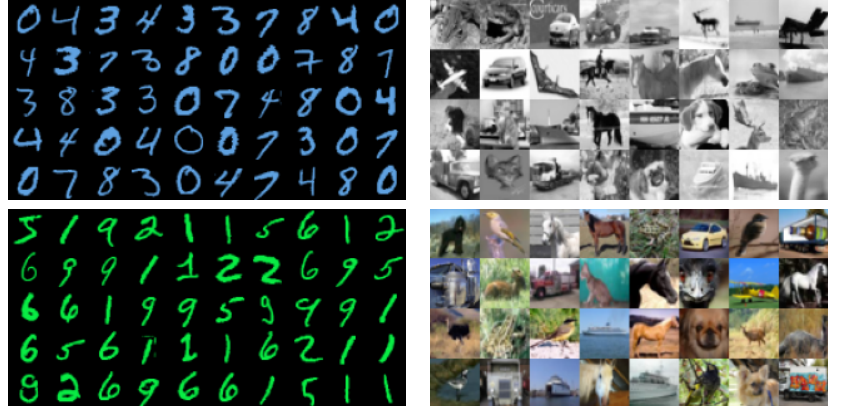
Figure 2. Examples of the images in the (modified) benchmark datasets. Left: The colored digits in the 2cMNIST dataset. These are generated by coloring the greyscale images in either blue or green (full details in text). When converted back to greyscale, all these examples have the same luminance. Right: Greyscale and color versions of the images in the CIFAR-10 dataset. Best viewed in